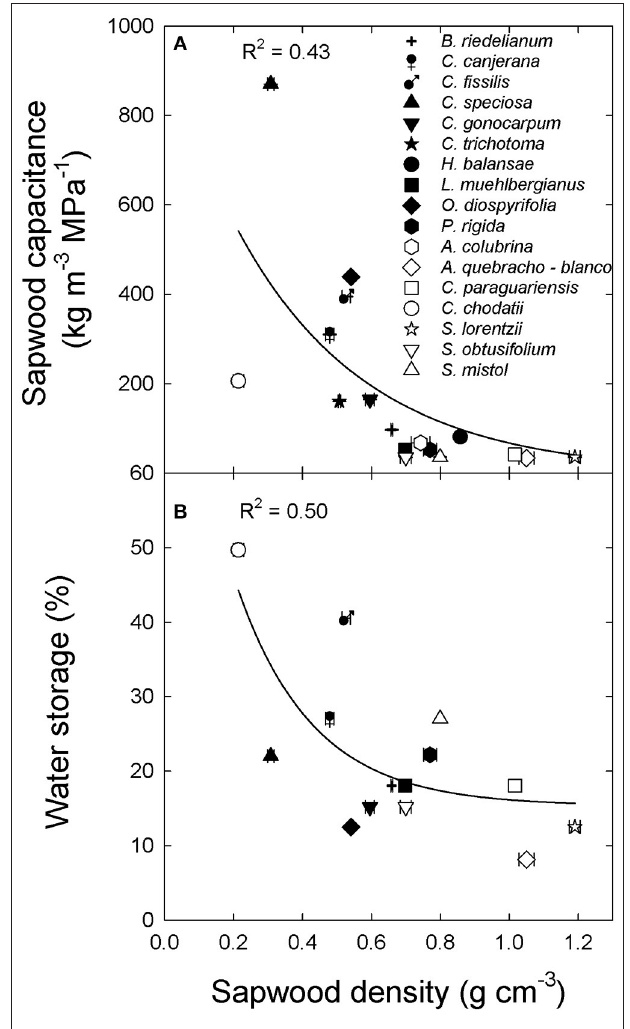
FIGURE 3 | (A) Sapwood capacitance and (B) contribution of water storage to daily transpiration (water storage) and sapwood density for tree species from the extremes of a precipitation gradient in northern Argentina. Black symbols correspond to wet extreme and white symbols to dry extreme. The lines are the functions fitted to the data [ (A) y = y = 144x, p < 0.001; (B) y = 15.3 + 76.5 exp − 4.5x , p <